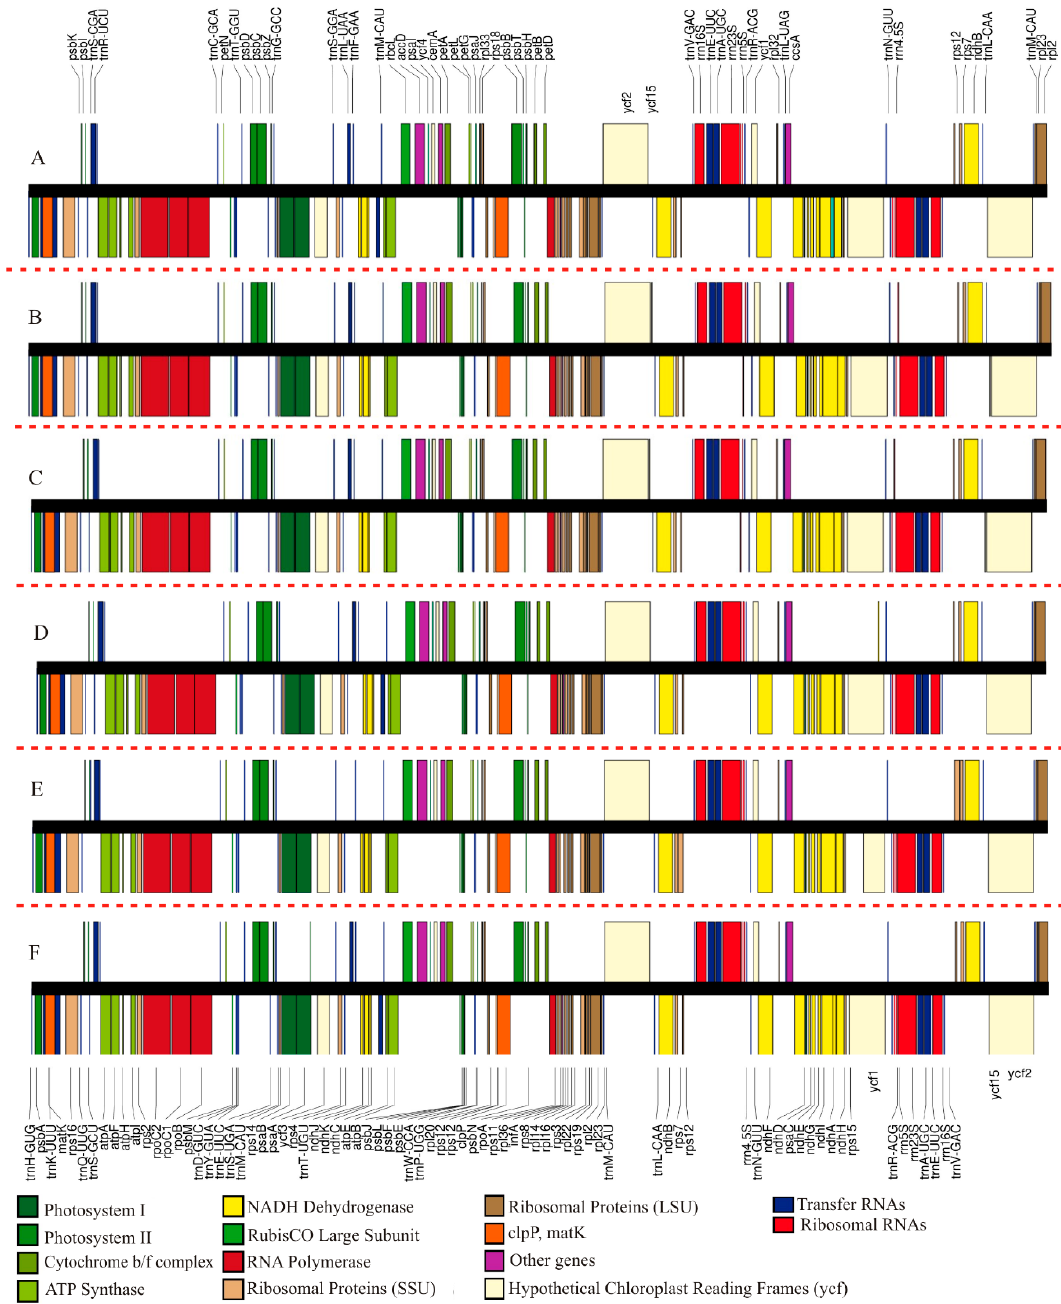
Figure 1. Linear chloroplast genome maps of six taxa of sect. Saintpaulia ( A : Str. teitensis ; B : subsp. velutinus ; C : subsp. grandifolius ; D : subsp. orbicularis ; E : subsp. grotei and F : subsp. rupicola ) . The genes above the black line (names on top of the figure) represent clockwise transcription while genes below (names at the bottom) are transcribed counter-clockwise. Genes of different functional categories are colored according to the legend at the bottom.